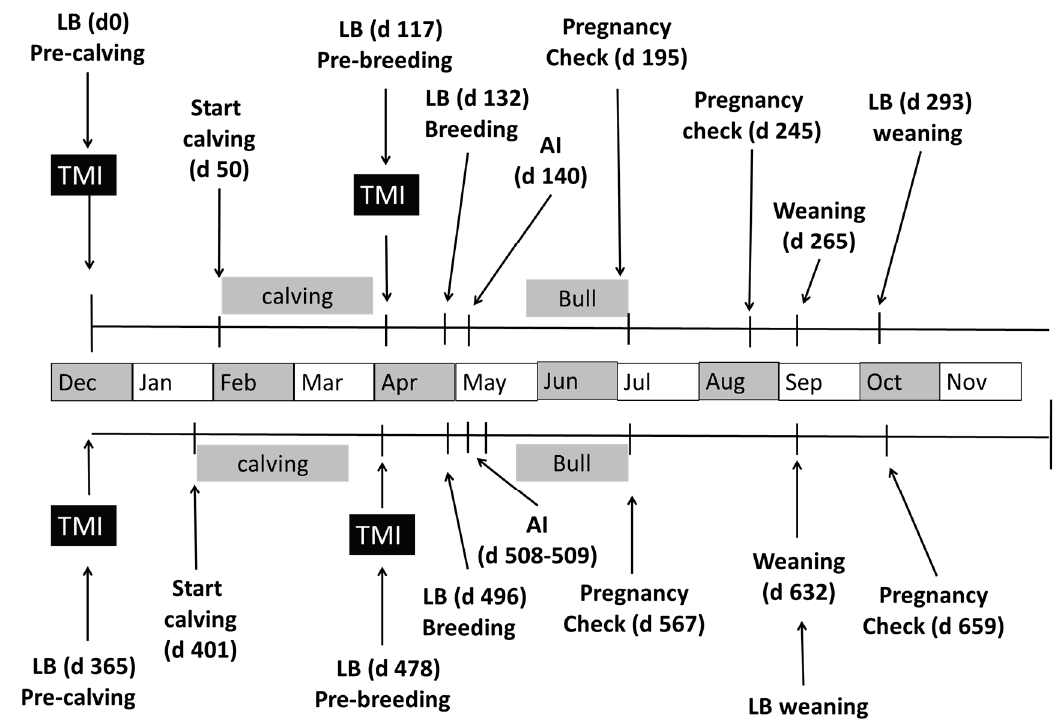
Figure 1. Timeline of two-year trial evaluating the impact of trace mineral injection (TMI) of beef cows on trace mineral concentration in liver (LB) and effects on cow reproduction and calf growth. Injections were given to cows pre-calving (days 0 and 365) and pre-breeding (days 117 and 478), and liver biopsies were taken prior to injection on those dates. Liver samples were also taken 15 to 18 days post pre-breeding TMI (days 132 and 496) and near weaning (days 293 and 632). Cows were estrus synchronized and artificially inseminated (AI), then exposed to fertile bulls. Pregnancy was determined using ultrasonography (days 195 and 567) to determine pregnancy due to AI and by rectal palpation (days 245 and 659) to determine the overall pregnancy rate.